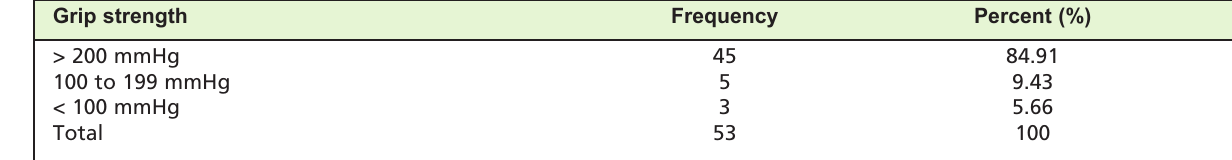
Table II: Demonstrating frequency of grip